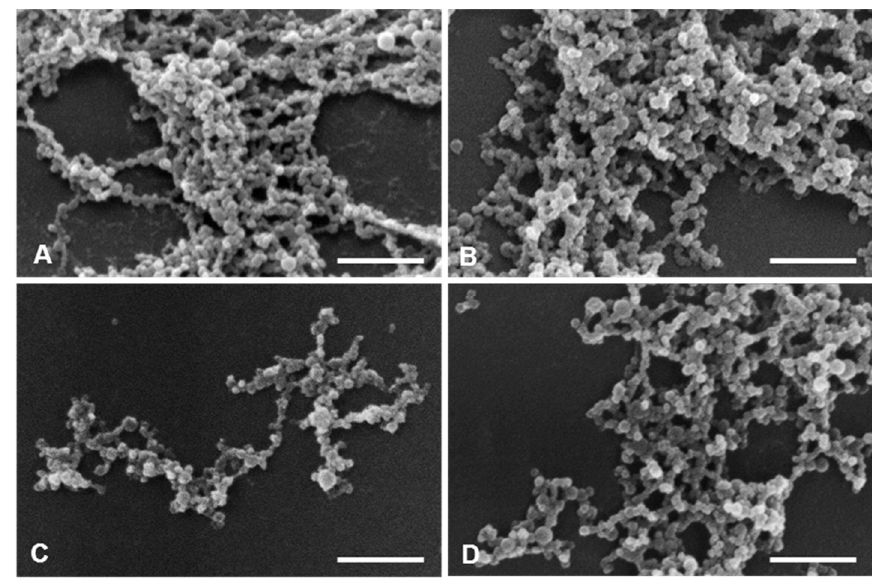
Figure 11. SEM images of BSA NPs. ( A ) empty ERL conjugated NPs; ( B ) PvD-loaded non-conjugated NPs; ( C ) ERL conjugated PvD-loaded NPs; ( D ) empty non-conjugated NPs. Scale bars = 1 μ m.